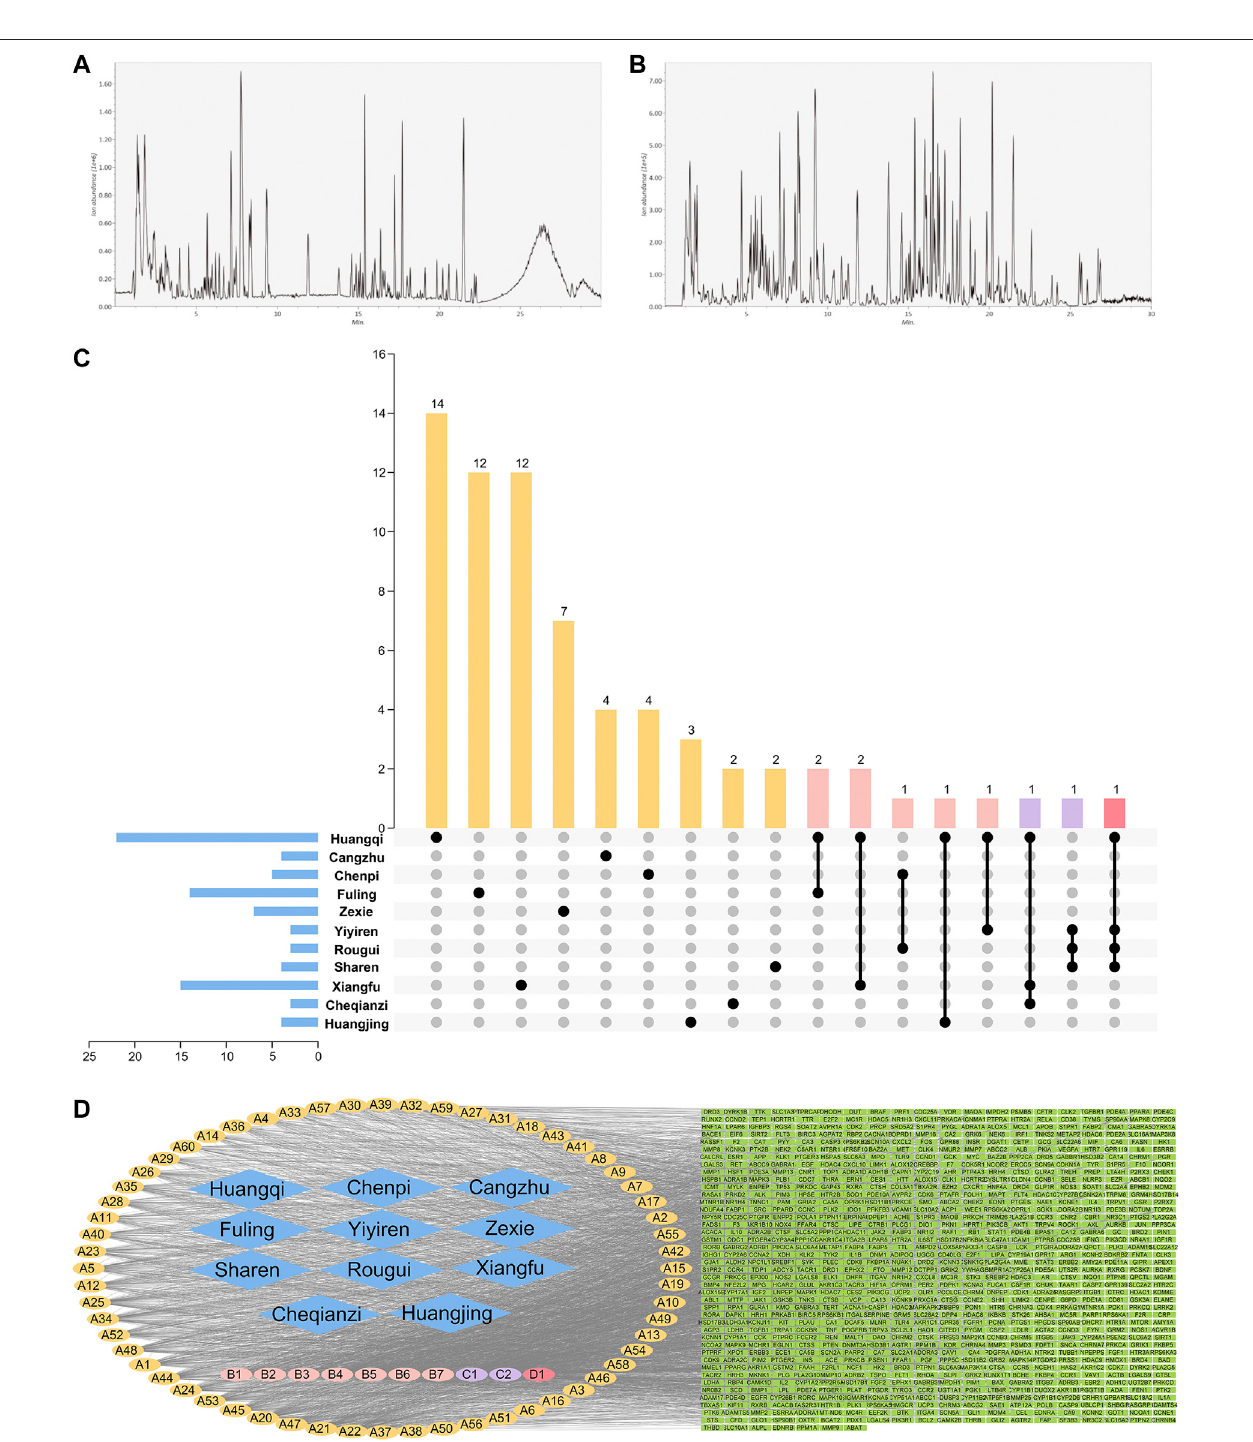
FIGURE2| Positiveion (A) andnegativeion (B) UPLC-MS/MSchromatographyofHTSJD. (C) ThenumberofuniqueandsharedingredientsofeachHTSJDherb. (D) The HTSJD ingredient-target visual network. Diamond nodes represent herbal medicines, oval nodes represent compounds, and square nodes represent targets. Compounds appearing in only one drug are highlighted yellow and denoted (A) . Compounds that appeared in two drugs are highlighted pink and denoted (B) . (C,D) represent common ingredients in three and four drugs, purple and red, respectively. The edges indicate interactions between compounds and the targets.